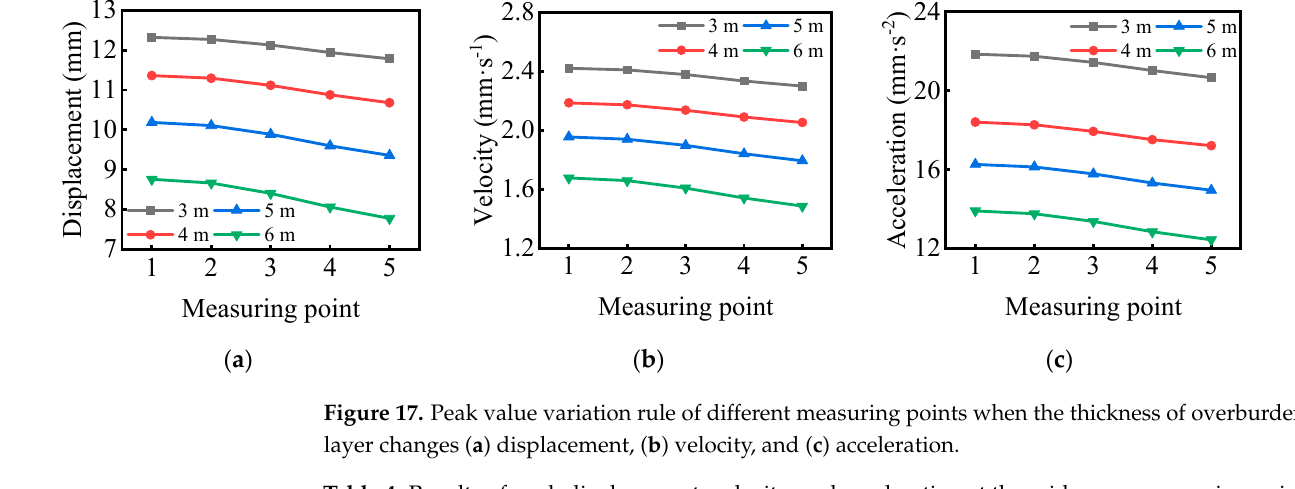
Table 4. Results of peak displacement, velocity, and acceleration at the mid − span measuring point when the thickness of overburden layer changes.